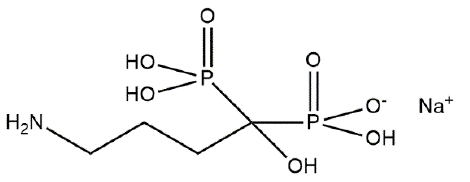
Figure 9. Schematic representation of alendronate sodium’s chemical structure.